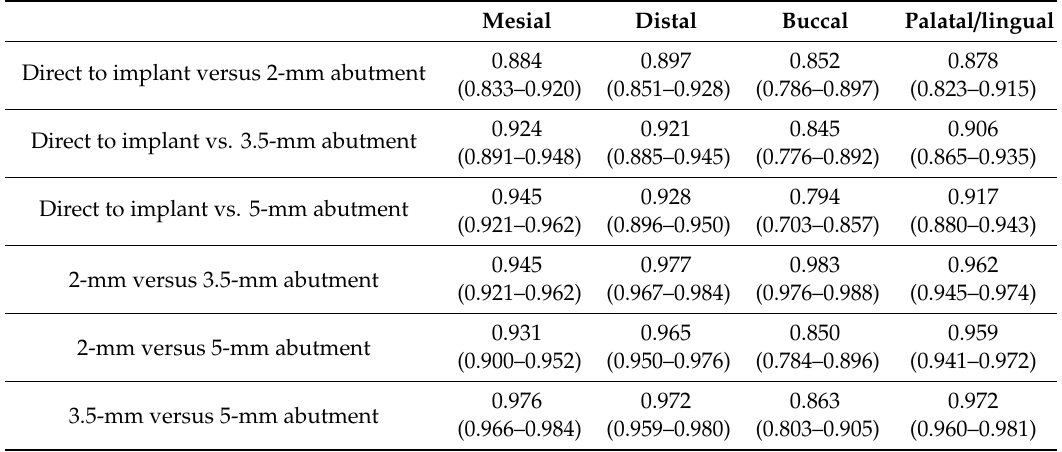
Table 5. ICC value achieved according to Osstell probe orientation, in relation to the di ff erent abutment heights between them p < 0.001 (CI